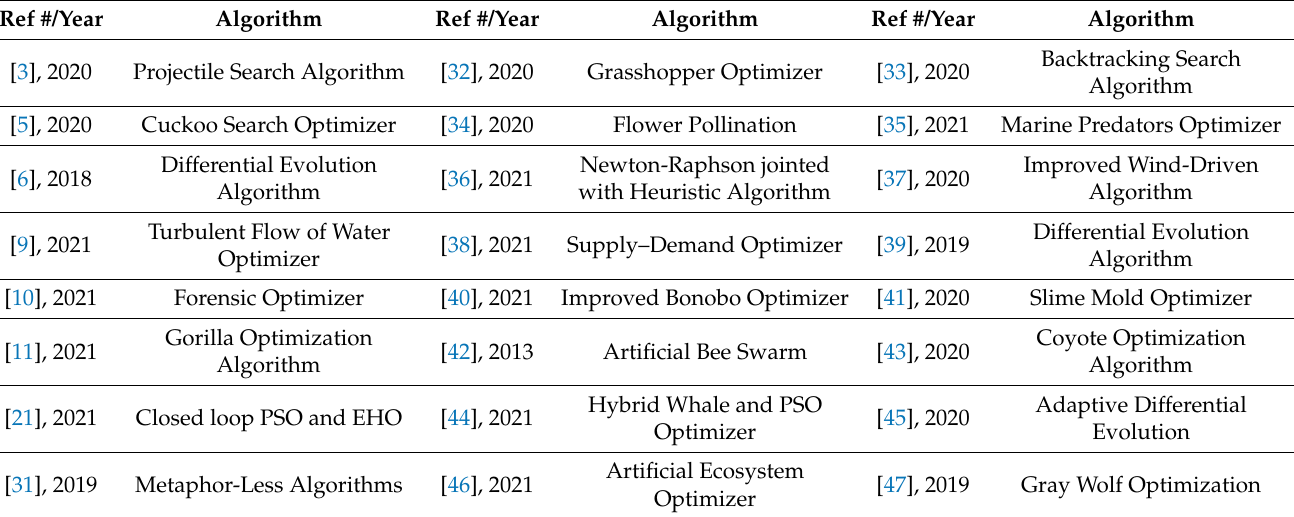
Table 1. Recent optimizers for PV parameter